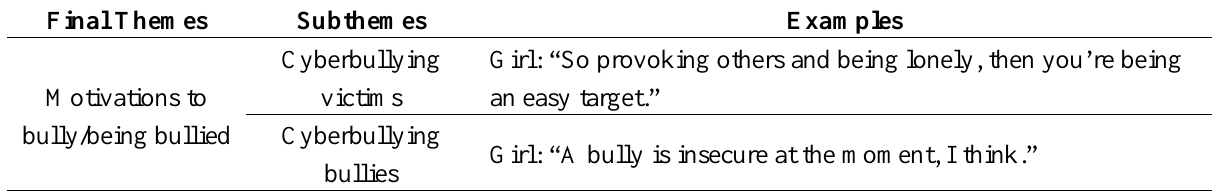
Table 6. Main themes, subthemes and examples for motivations for (cyber)bullying.